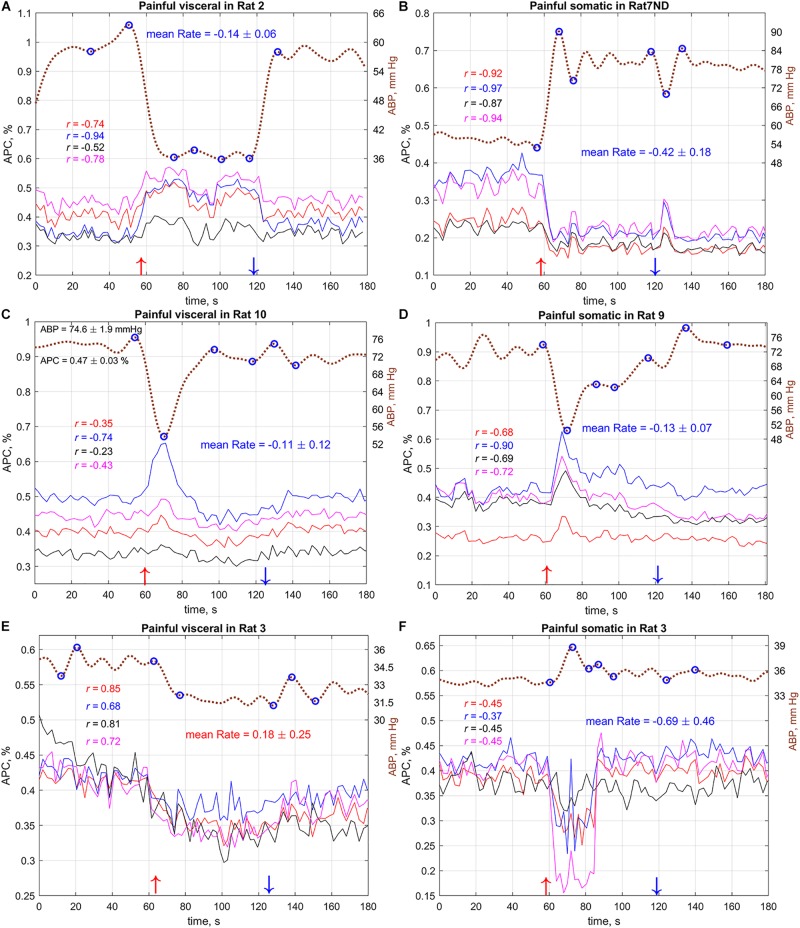
Typical (A–C) and atypical (D–F) dynamics of the systemic blood pressure and amplitude of pulsatile component in cerebral arteries of several rats during visceral and somatic stimulation. Dashed brown curves show dynamics of the mean arterial blood pressure with the labels on the right. Solid colored lines show APC measured in big ROIs selected in different areas of the cortex. Marker “ND” in the rat’s name above the graphs means that the measurements were carried out without dura mater. Color of a correlation coefficient corresponds to the color of APC curve in each panel. Red and blue arrows nearby the X-axes show moments of the beginning and end of stimulation, respectively. The complete set of the responses for all 11 rats (with and without dura mater) is available in Supplementary Figures S1–S21.